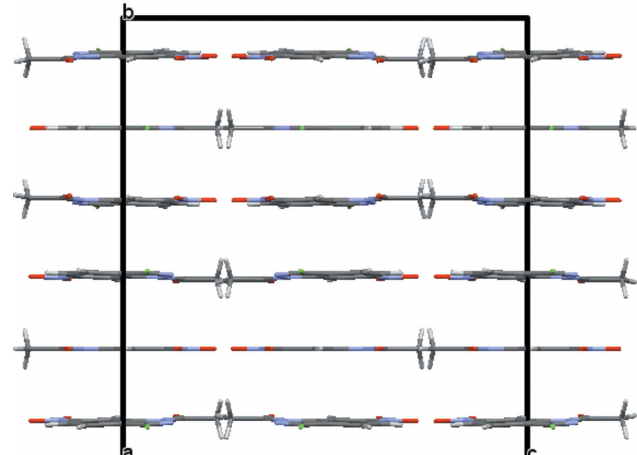
Figure 4 , z .] Cg 2 = centroid(C2– Packing viewed along the a -axis direction, showing the layer 2